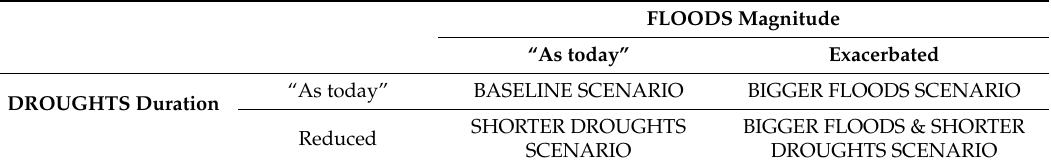
Table 5. Summary of future hydrological scenarios considered in this study.